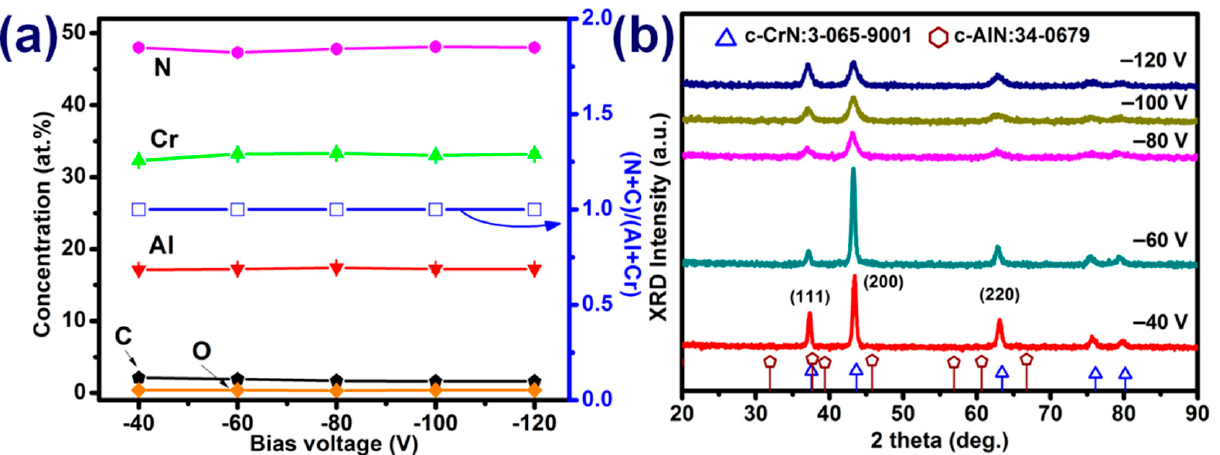
Figure 6. ( a ) Elements concentrations and ( b ) XRD profiles of AlCrCN films as a function of bias voltage.